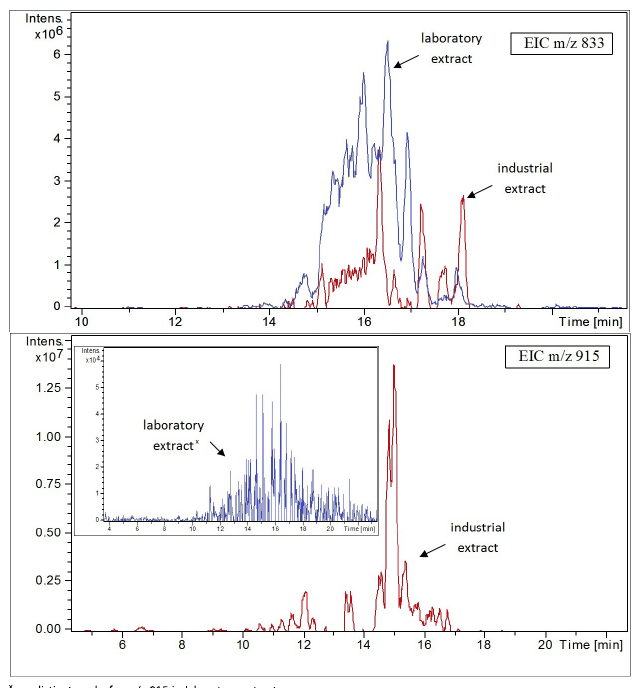
Fig. 4: Extracted ion chromatogram (EIC) of unsulfited (m/z 833) and sul - fited trimer (m/z 915) for industrial (red) and laboratory (blue) que - bracho